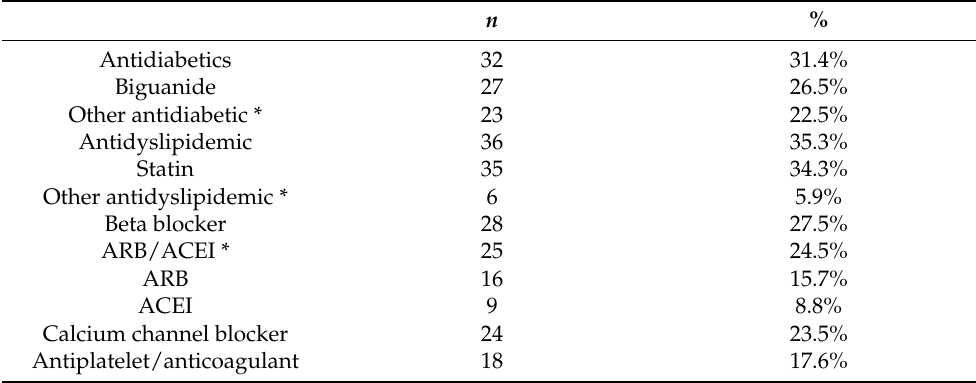
Table 2. Type and prevalence of medications used by